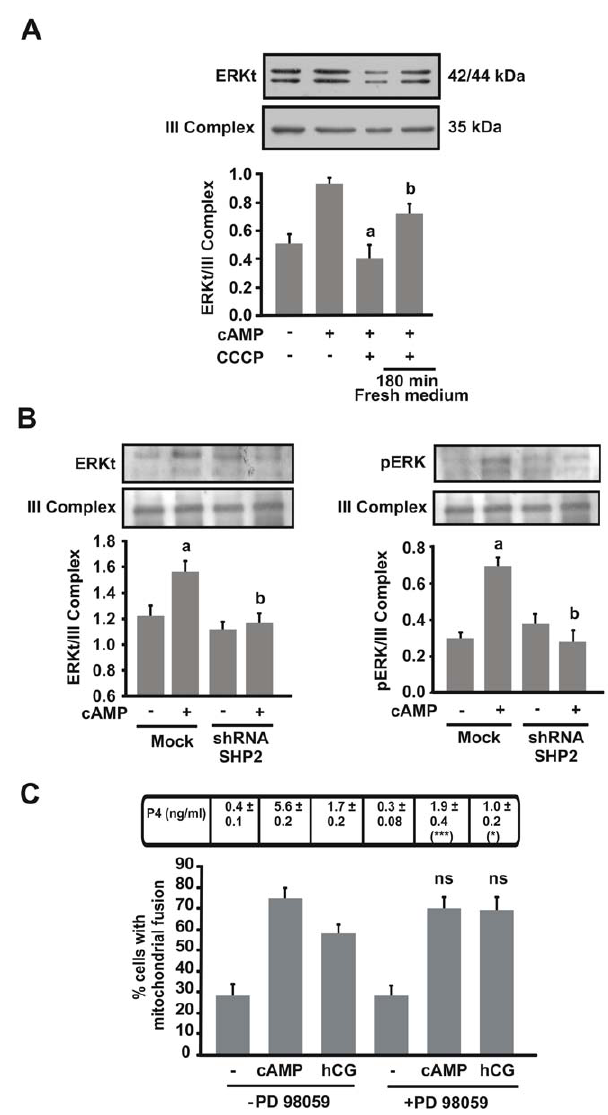
Figure 6. Mitochondrial fusion could allow access of ERK into mitochondria. A. MA-10 cells were treated with or without CCCP (5 m M) and 8Br-cAMP (1 mM) for 1 h, or incubation with CCCP and 8Br- cAMP for 1 h followed by washout and 3 h recovery. Mitochondria were isolated and western blotting was performed. An image of a representative western blot is shown (Top panel). Membranes were sequentially blotted with anti-ERKt and anti-III Complex antibodies. For each band, the OD of the expression levels of ERKt protein was quantified and normalized to the corresponding III Complex protein. The relative levels of ERKt protein are shown. Data are presented as an average SEM of three independent experiments. a P , 0.001 vs. cAMP and b P , 0.01 vs. control. B. Left panel: MA-10 cells were transfected with the shRNA1 SHP2 plasmid. After 48 h, mitochondria were isolated and western blotting was performed. An image of a representative western blot is shown. Membranes were sequentially blotted with anti- ERKt (total ERK) and anti-III Complex antibodies. For each band, the OD of the expression levels of ERKt protein was quantified and normalized to the corresponding III Complex protein. The relative levels of ERKt protein are shown. Right panel: an image of a representative western blot is shown. Membranes were incubated with a stripping buffer and blotted with anti-pERK (phosphorylated ERK). For each band, the OD of the expression levels of pERK protein was quantified and normalized to the corresponding III Complex protein. The relative levels of pERK protein are shown. The results are expressed as the means 6 SEM